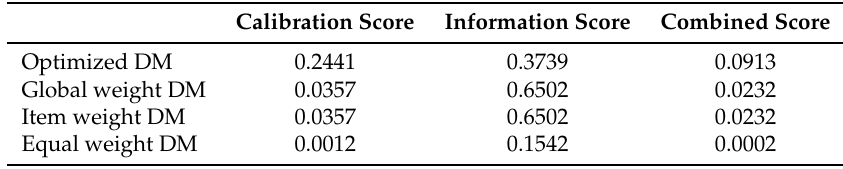
Table 4. Performance of the different Decision Makers for panel